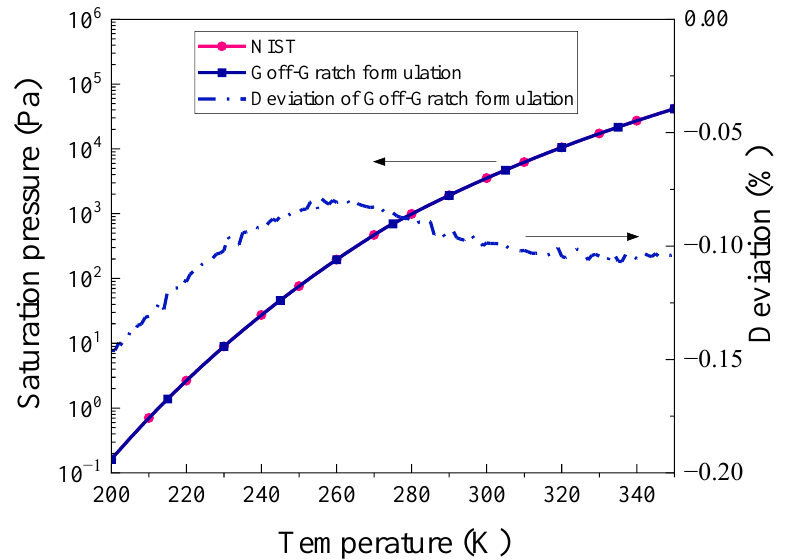
Figure 3. Performance of the Goff–Gratch formulation for water vapor saturation pressure estima- tion.